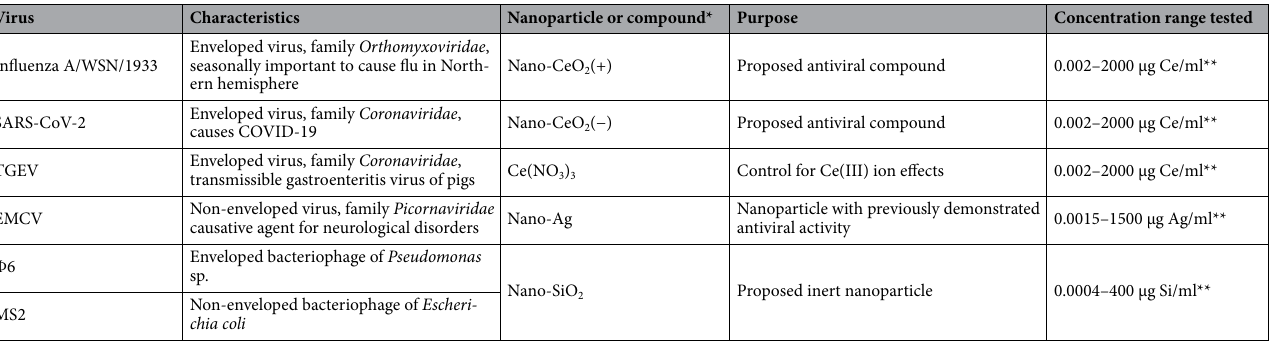
Table 2. Characteristics of viruses used in antiviral assays. Right side of the table shows characteristics and concentrations of nanoparticles and chemical compounds used in antiviral assays with every virus listed in the left side of the table. *All the compounds were tested with all the viruses. **All the tested nanoparticles and chemicals were in the range of 0.014–14,000